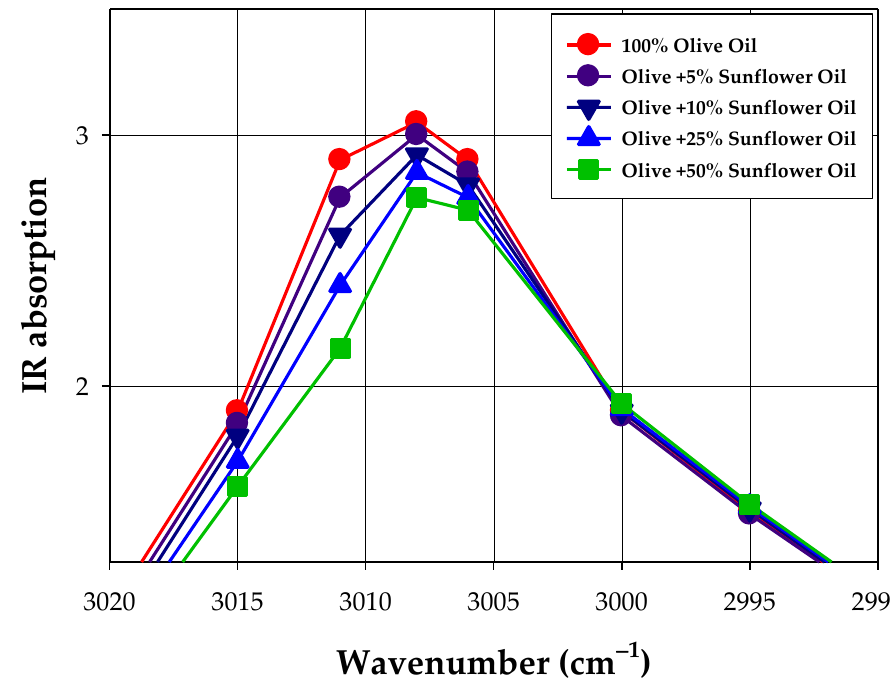
Figure 7. IR absorption spectra for olive and sunflower oils and their 50-50 mixture.